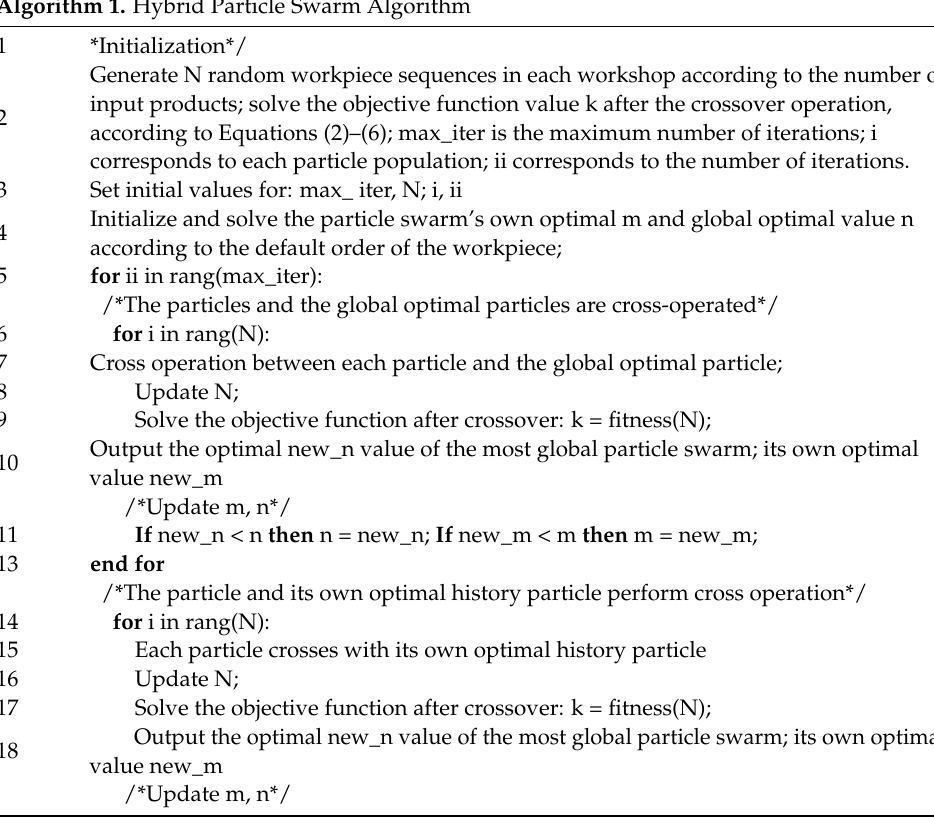
Algorithm 1. Hybrid Particle Swarm